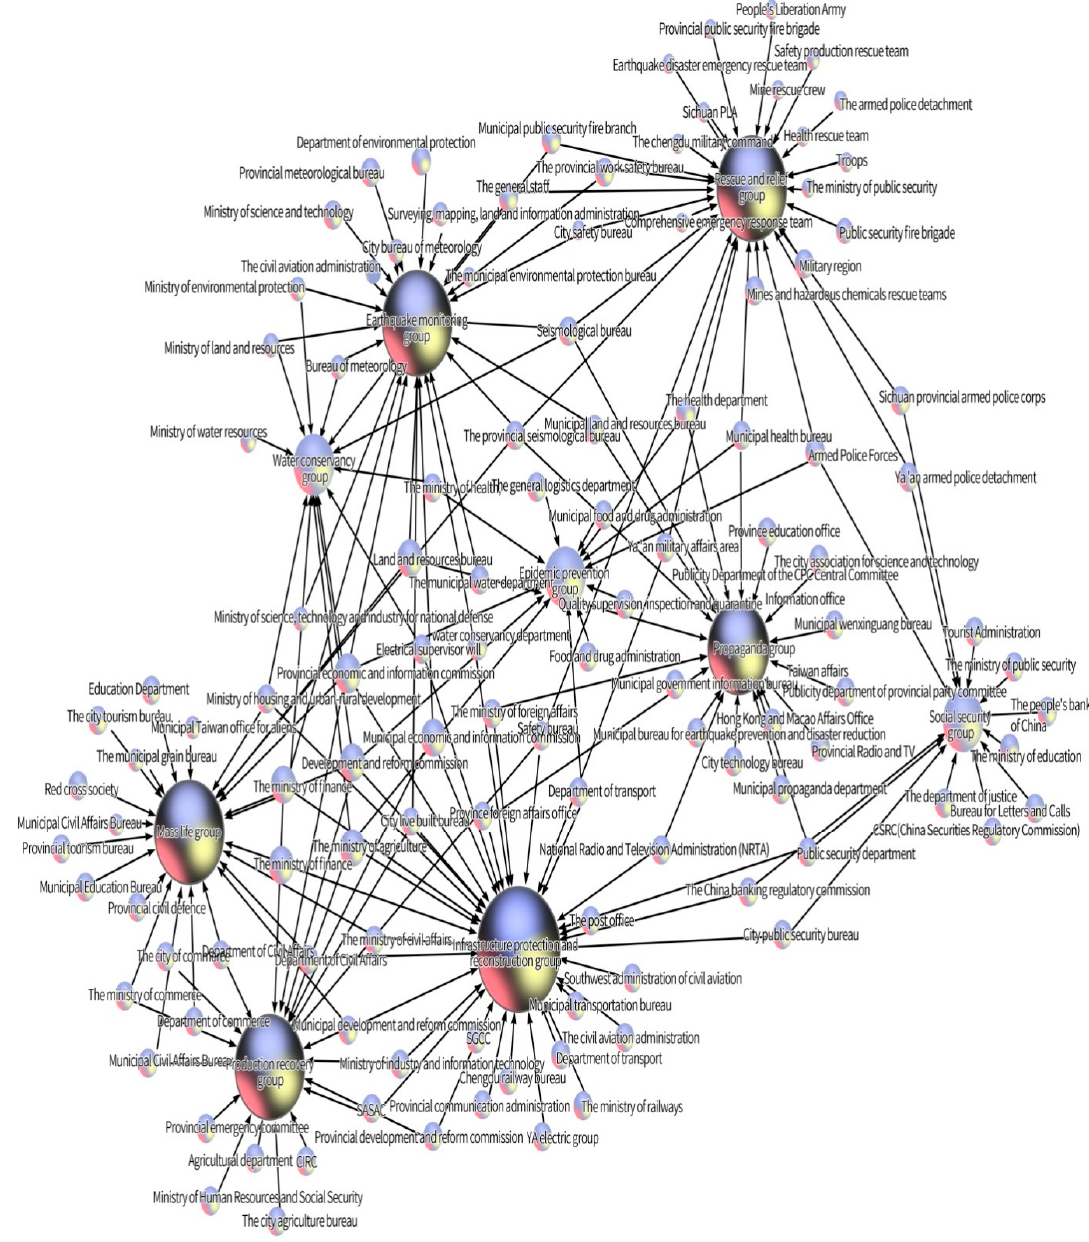
Figure 3. Institutionalized emergency organization network (due to limited space, this figure is blurry; readers may e-mail the authors for a clearer figure).